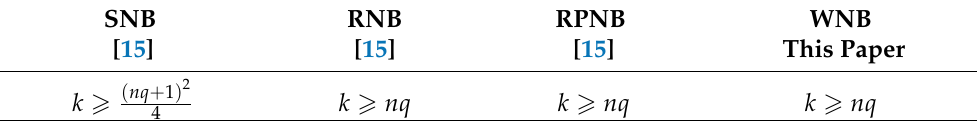
Table 1. Nonblocking conditions for the CC ( q , r ,1, n , k ) switching fabrics with m max = n . SNB RNB RPNB WNB [15] [15] [15] This